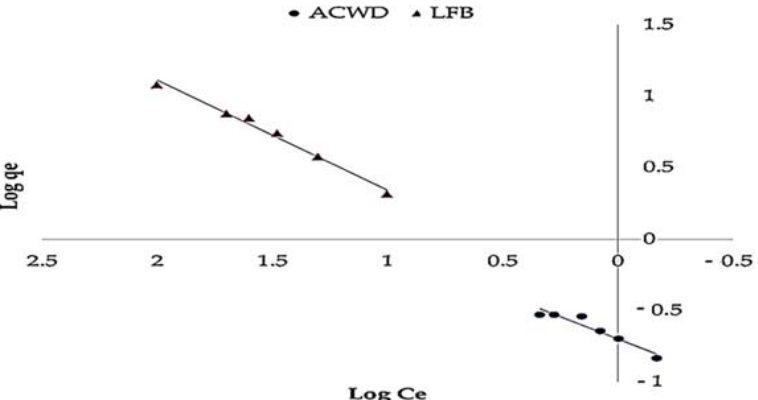
Figure 8. Freundlich isotherm plot for the sorption of ammonia using whole biomass (ACDW) and lipid ‐ free biomass (LFB) of Arthrospira platensis.